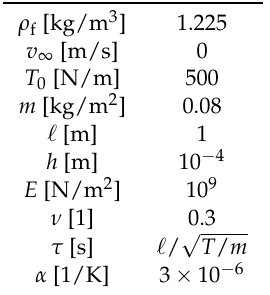
Table 1. Problem parameters used in the numerical examples.